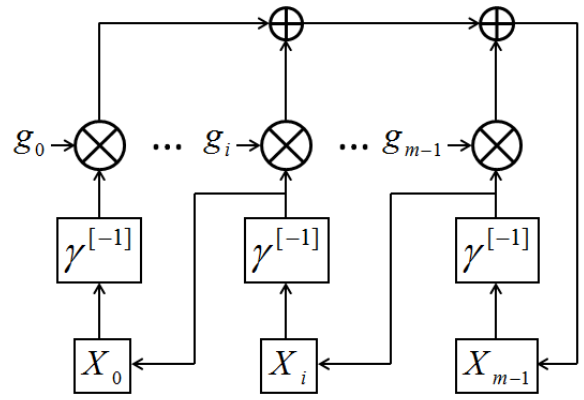
Figure 1: Skewed LFSR